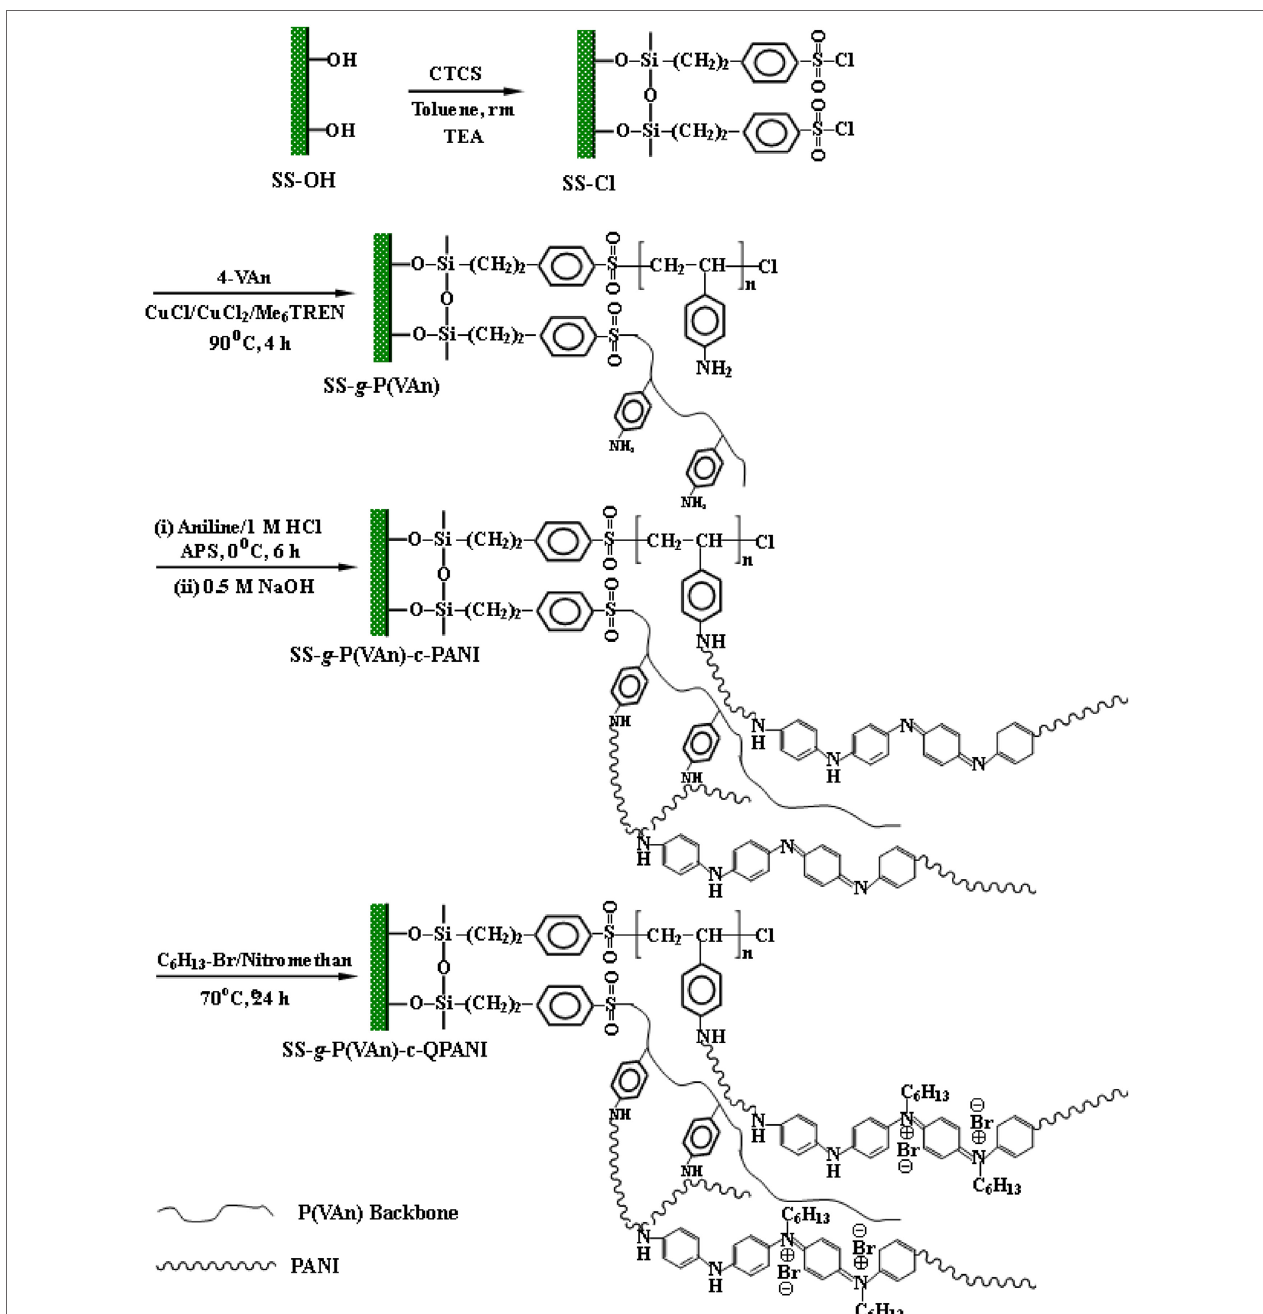
FiGURe 8 | Schematic diagram illustrating the process of surface-initiated atom transfer radical polymerization of 4-vinylaniline (VAn), subsequent chemical oxidative polymerization of aniline on the PVAn-grafted surface to generate the PVAn- g -polyaniline bilayer-coated surfaces and finally N -alkylation to give rise to antibacterial functionality. Reprinted with permission from Yuan et al. (2012). Copyright 2012 American Chemical